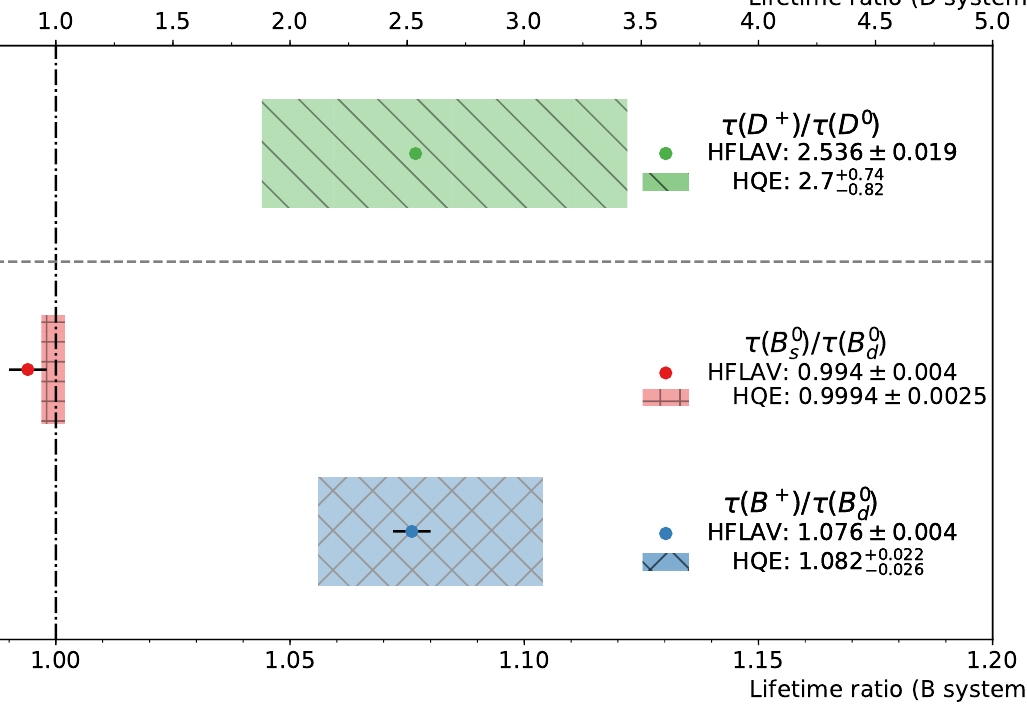
Figure 9 . Comparison of our predictions for the lifetime ratios of heavy mesons with the present experimental averages.